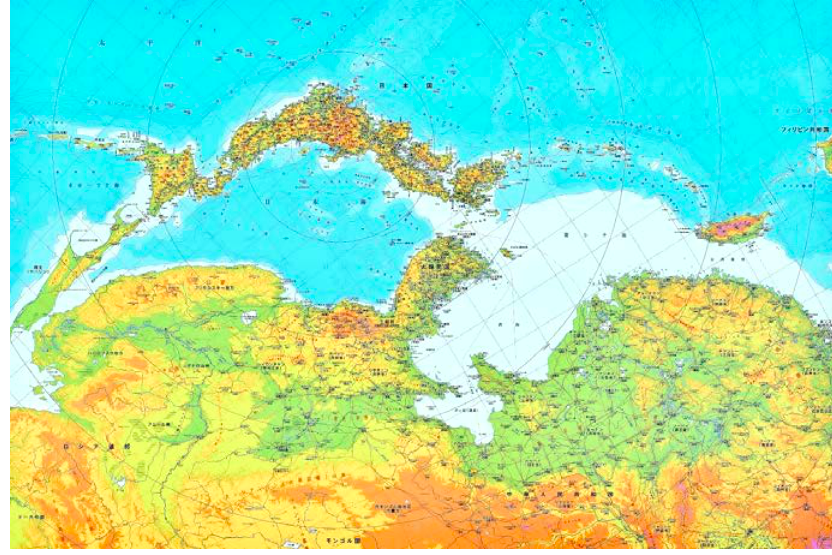
Figure 2. Map of East Asian Countries on the Sea of Japan. 44 .